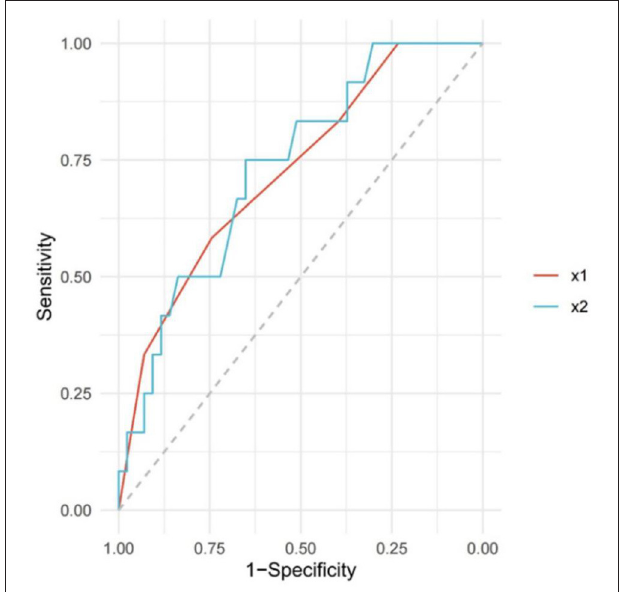
FIGURE 3 | Receiving operating characteristic (ROC) curve of pc-ASPECTS and OPT. The red solid line (x1) represents the boundary of the pc-ASPECTS area under the curve (AUC), and the blue band (x2) represents the boundary of onset-to-puncture time (OPT). The predictive performance indexes of this scale at different cutoff values are shown in Table 3 . ROC, Receiver-operating Characteristic; OPT, Onset-to-puncture time; AUC, Authentication Center.